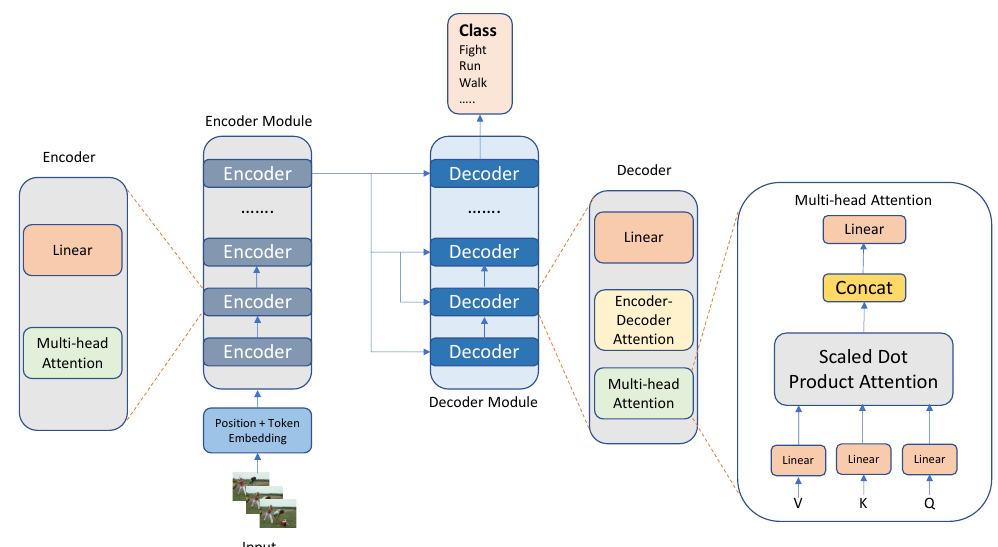
Figure 14. An overview of the video